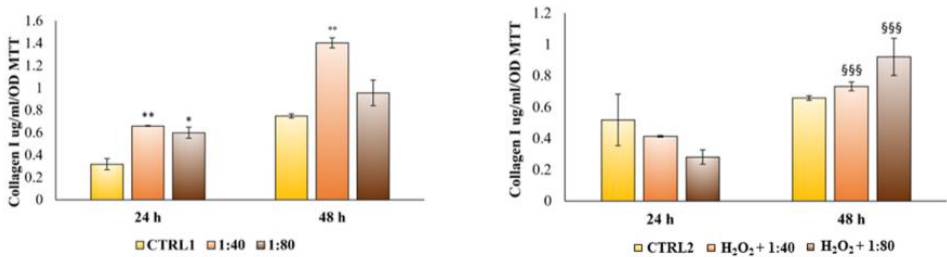
Figure 10. Enzyme-linked immunosorbent assay (ELISA) for collagen I secretion in HGFs exposed to DMEM culture medium (CTRL1), to SS diluted 1:40 and 1:80 and of HGFs pre-treated with H 2 O 2 100 µ M then exposed to DMEM culture medium (CTRL2) and to SS diluted 1:40 and 1:80 for 24 and 48 h. Secretion levels are reported as µ g/mL/MTT OD viable cells. The most representative of three separate experiments is shown. The bar graph displays densitometric values expressed as mean ± standard deviation. ** vs. CTRL1 p = 0.0058, * vs. CTRL1 p = 0.0102, ◦◦ vs. CTRL1 p =